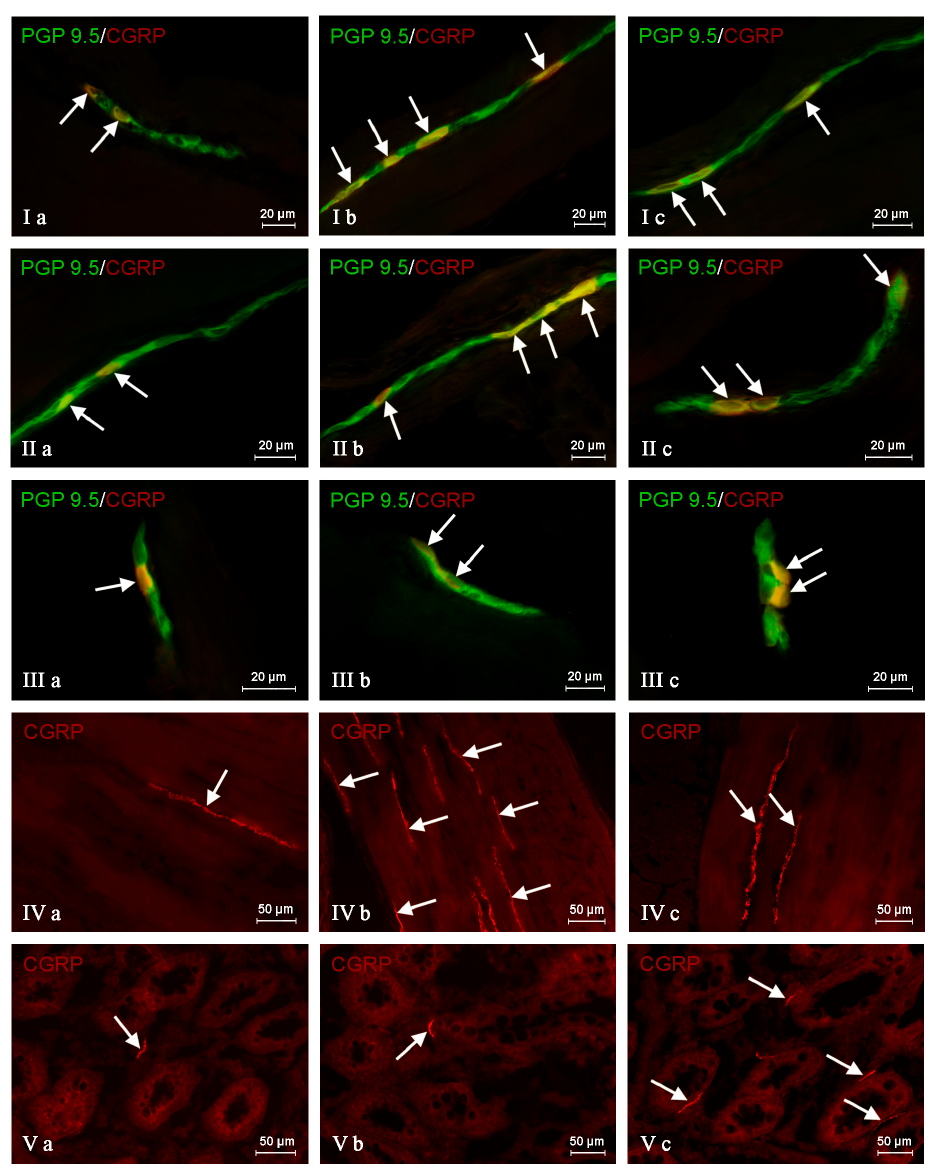
Figure 2. Distribution pattern of nervous structures immunoreactive to protein gene-product 9.5 (PGP 9.5), used as a pan-neuronal marker and calcitonin gene-related peptide (CGRP) in the wall of the porcine descending colon under physiological conditions ( a ), after axotomy ( b ) and during inflammation ( c ). (I) Myenteric plexus; (II) outer submucous plexus; (III) inner submucous plexus; (IV) circular muscle layer and (V) submucous/mucous layer. CGRP-positive neurons (I–III) and nerve fibers (IV,V) are indicated by arrows. Images I, II and III are composites of merged images taken separately from green (PGP 9.5) and red (CGRP) fluorescent channels. Images IV and V were performed using a single immunofluorescence technique.